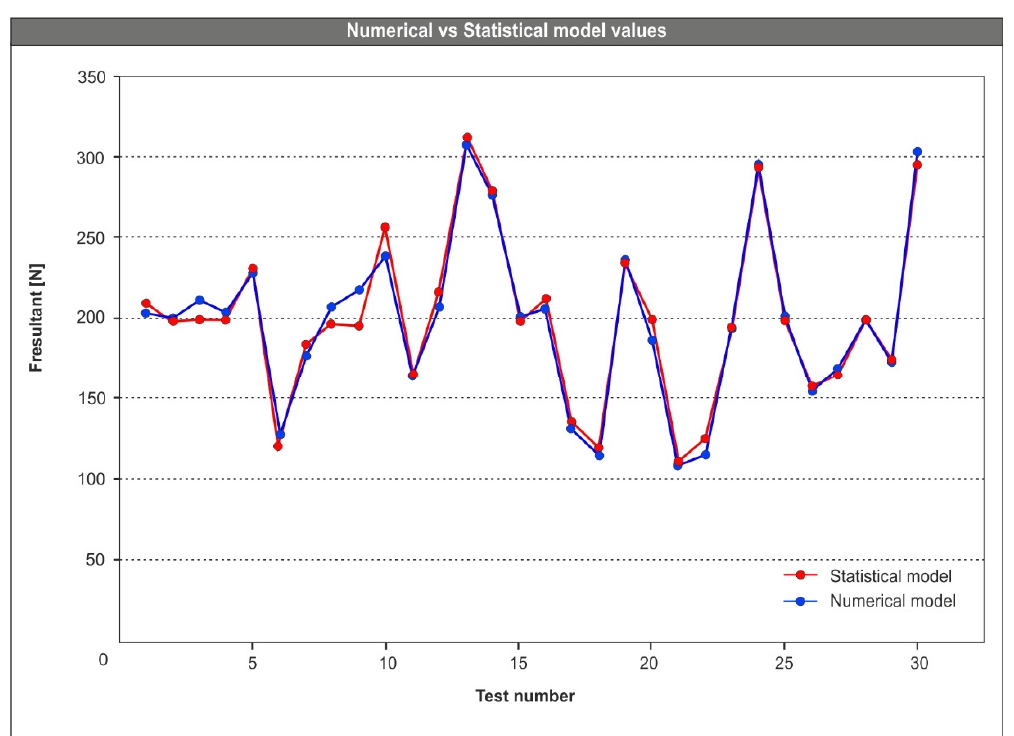
Figure 5. Comparison between predicted and simulated values of F resultant .